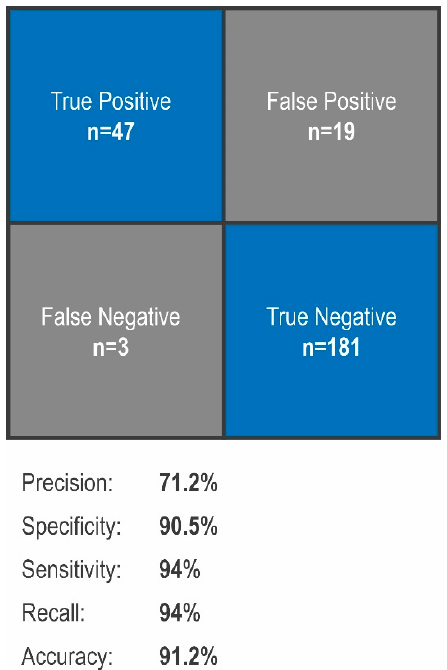
Figure 3. Validation of the Algorithm. Utilizing 200 nodule-free images and 50 images positive for nodules for external validation, precision of 71.2%, specificity of 90.5%, sensitivity of 94%, recall of 94% and accuracy of 91.2% could be determined.